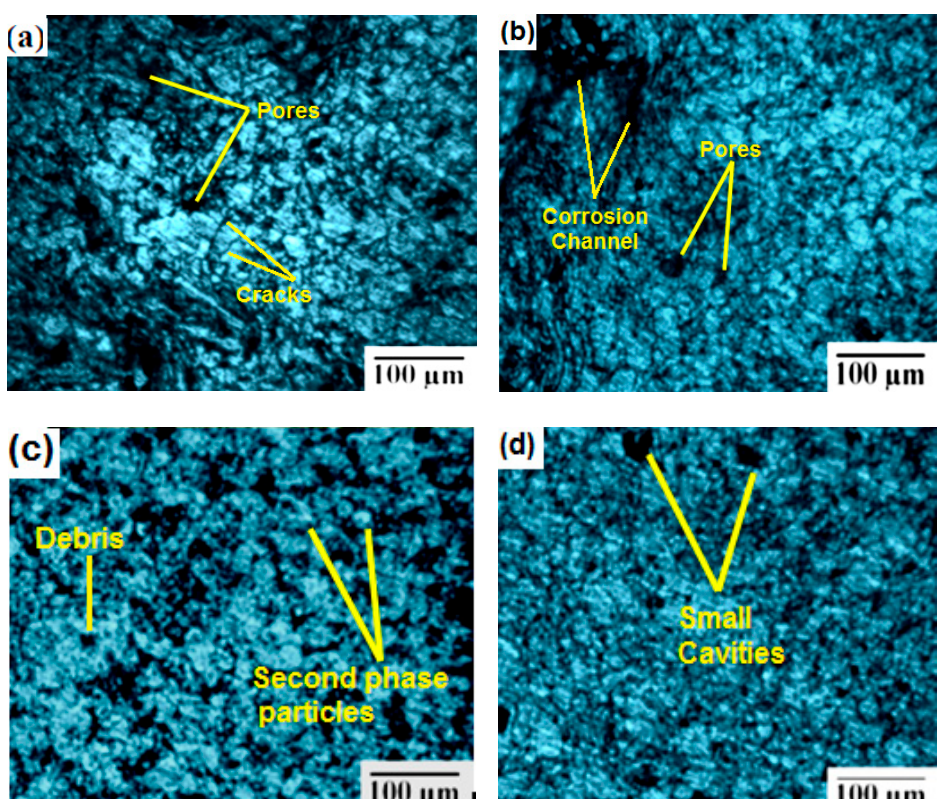
Figure 9. Optical microscopic image of corrosion test specimen: ( a ) Expt. 1, ( b ) Expt. 2, ( c ) Expt. 3, and ( d ) Expt. 4.